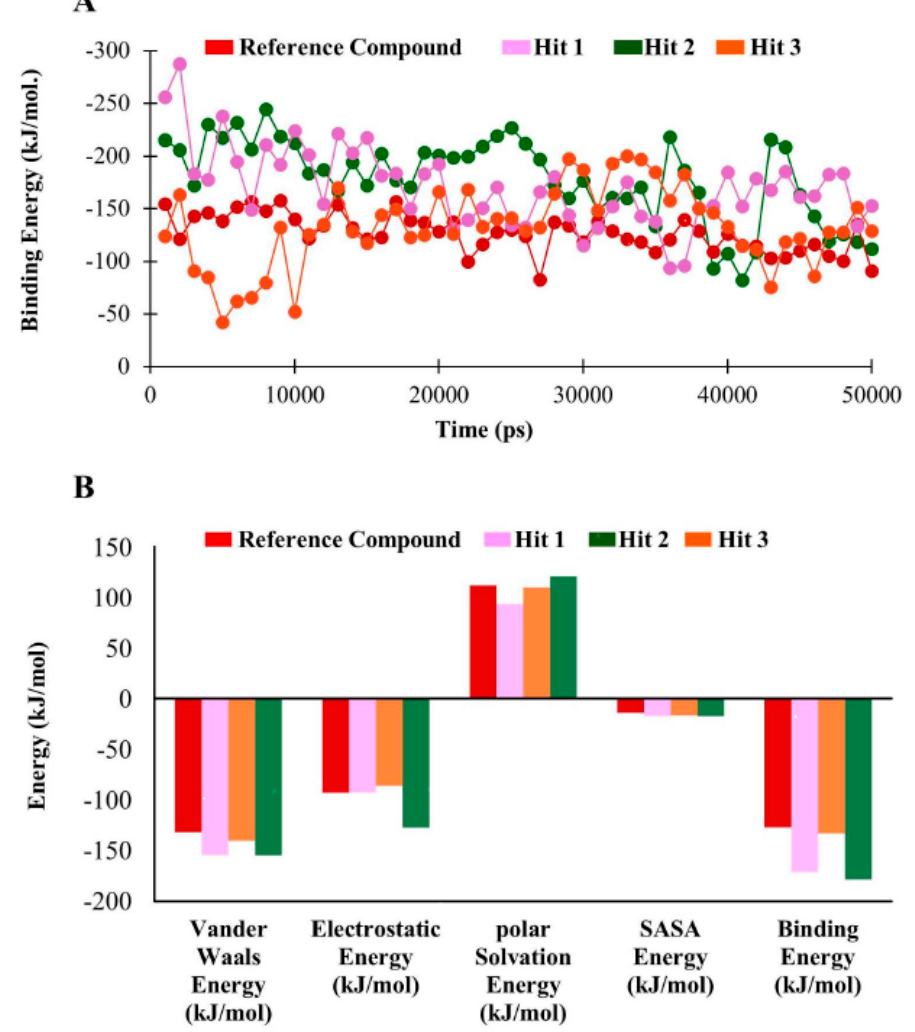
Figure 11. Binding free energy analyses. ( A ) Graphical representation of MM/PBSA estimated binding free energy of hDHFR in complex with reference compound, Hit1, Hit2, and Hit3 throughout the simulation time. The reference compound, Hit1, Hit2, and Hit3 are depicted as red, magenta, green, and orange, respectively. ( B ) The binding free energy decomposition analysis of the final hits in the active site of hDHFR. Table 7. Decomposition of binding free energy.